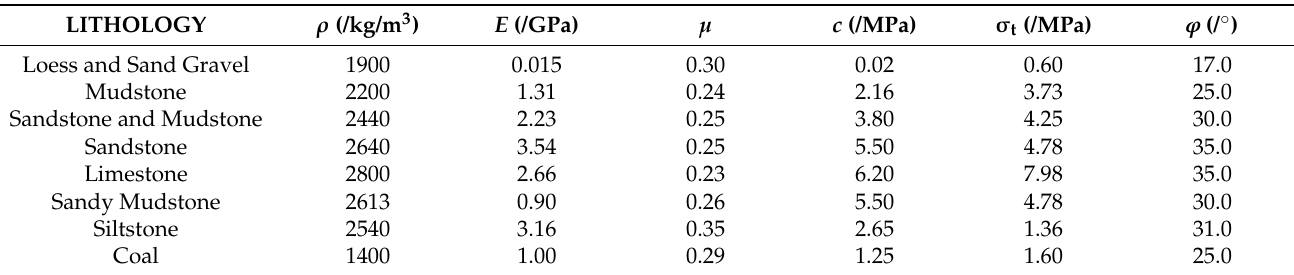
Table 1. Calculation parameters of rock mechanics.